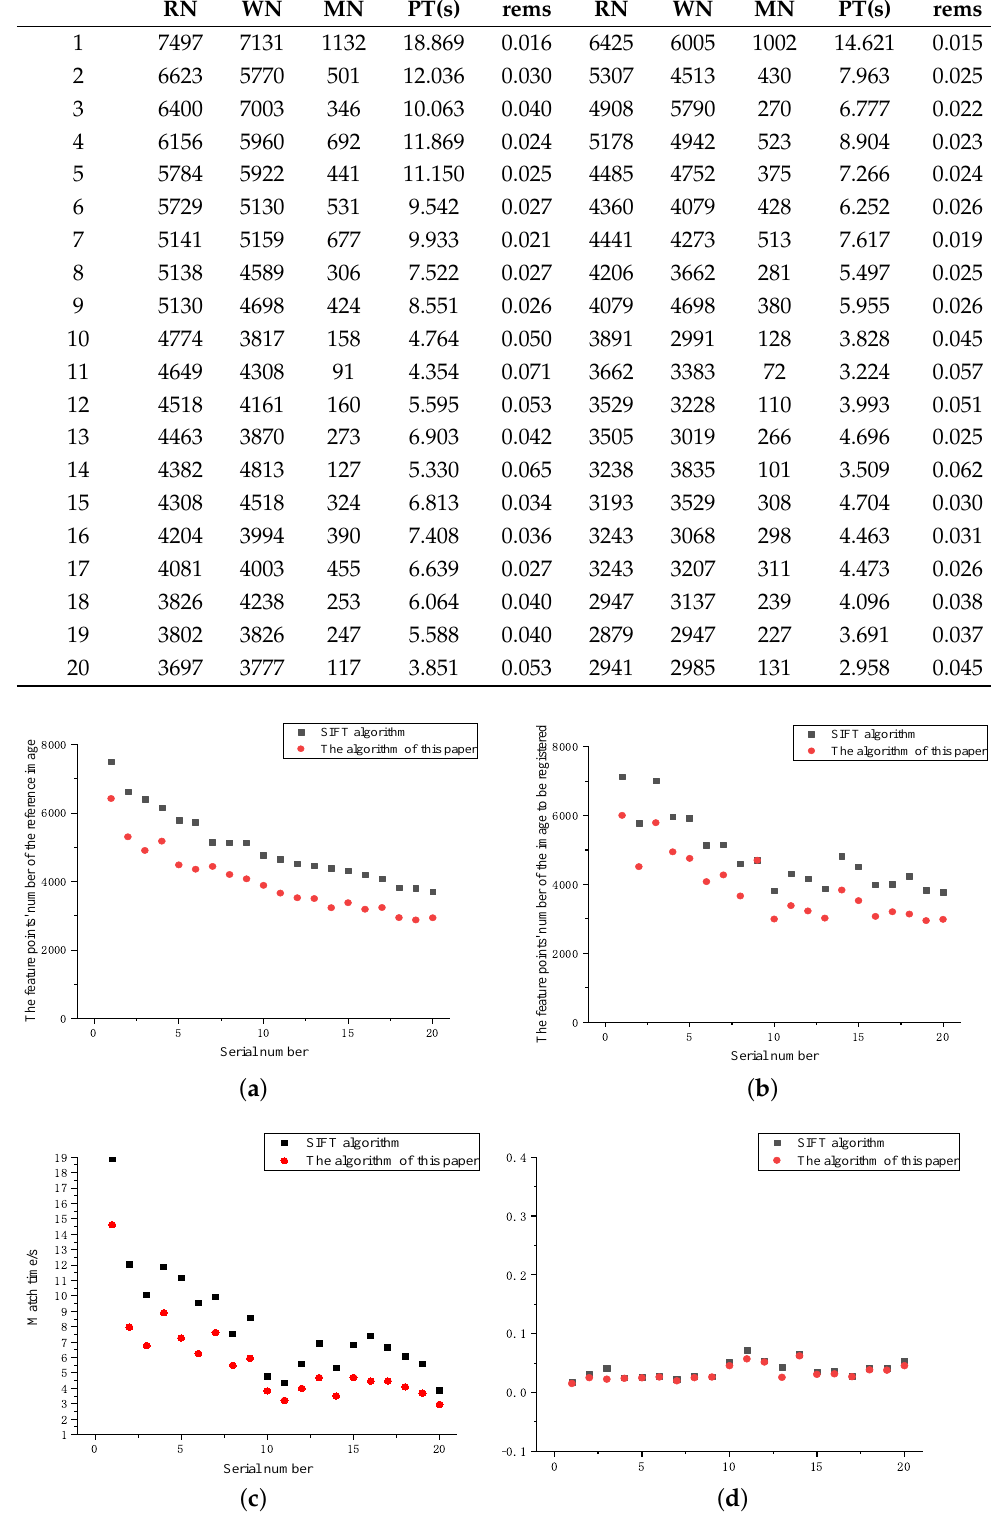
Figure 11. Comparison of the Euroc dataset’s specific experimental data in four caegories: ( a ) the number of feature points of the reference image; ( b ) the number of feature points of the images to be compared; ( c ) matching time; and ( d ) Rems